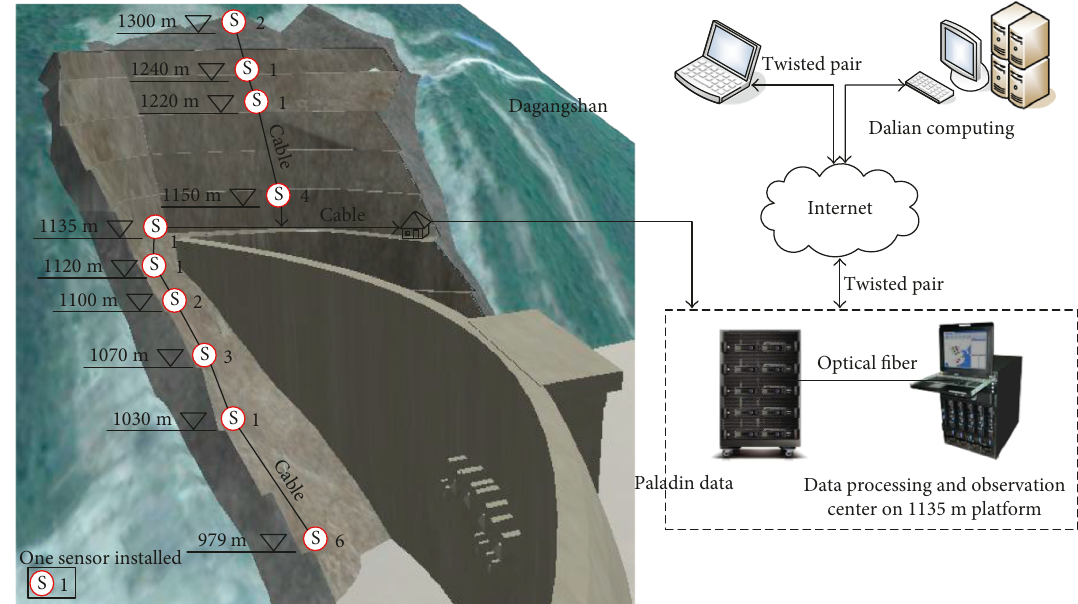
Figure 7: Topological graph of MS monitoring network in the right bank of the Dagangshan hydropower